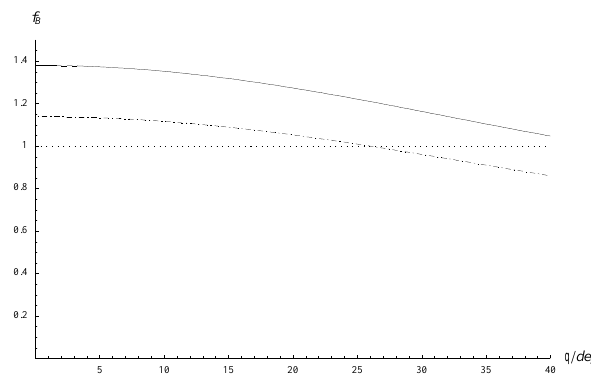
Fig. 3. Plot of the magnetic field factor f B appearing in the ex- pression for the horizontal ionospheric current (Eq. 13), given by Eq. (14). This term contains the effects on the current due to non- vertical fields, non-dipole fields, and the field variation with mag- netic latitude. The solid line shows values for the Northern Hemi- sphere, while the dot-dashed line shows values for the Southern Hemisphere, plotted versus co-latitude θ from the respective poles. The dotted line shows unity for purposes of